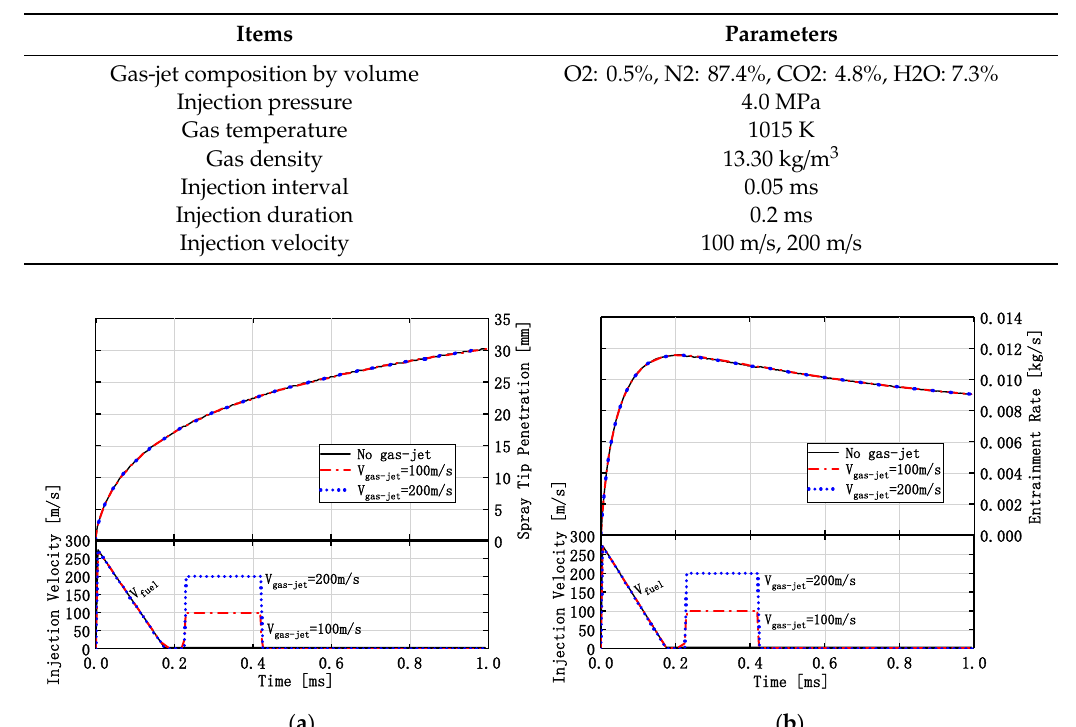
Table 5. The comparisons of spray tip penetration and entrainment rate between the ramping-down injection without gas-jet and the ramping-down injection with gas-jet are shown in Figure 13. It seems that whether there is gas-jet after EOI or not has no effect on the spray tip penetration and entrainment rate, which is related to the limited effect range of gas-jet. Figure 12. Schematic diagram of the ramping-down injection with gas-jet Figure 12. Schematic diagram of the ramping-down injection with gas-jet. Table 5. Calculation conditions for gas-jet. Table 5. Calculation conditions for gas-jet.